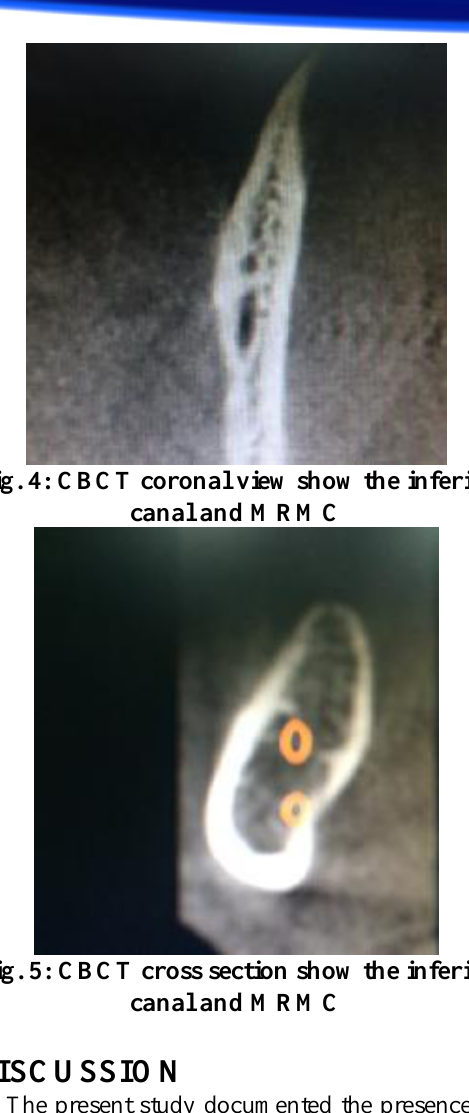
Fig. 2: CBCT, reconstructed panoramic view show type2 of MRMC which emerge from the inferior dental canal and directed upward